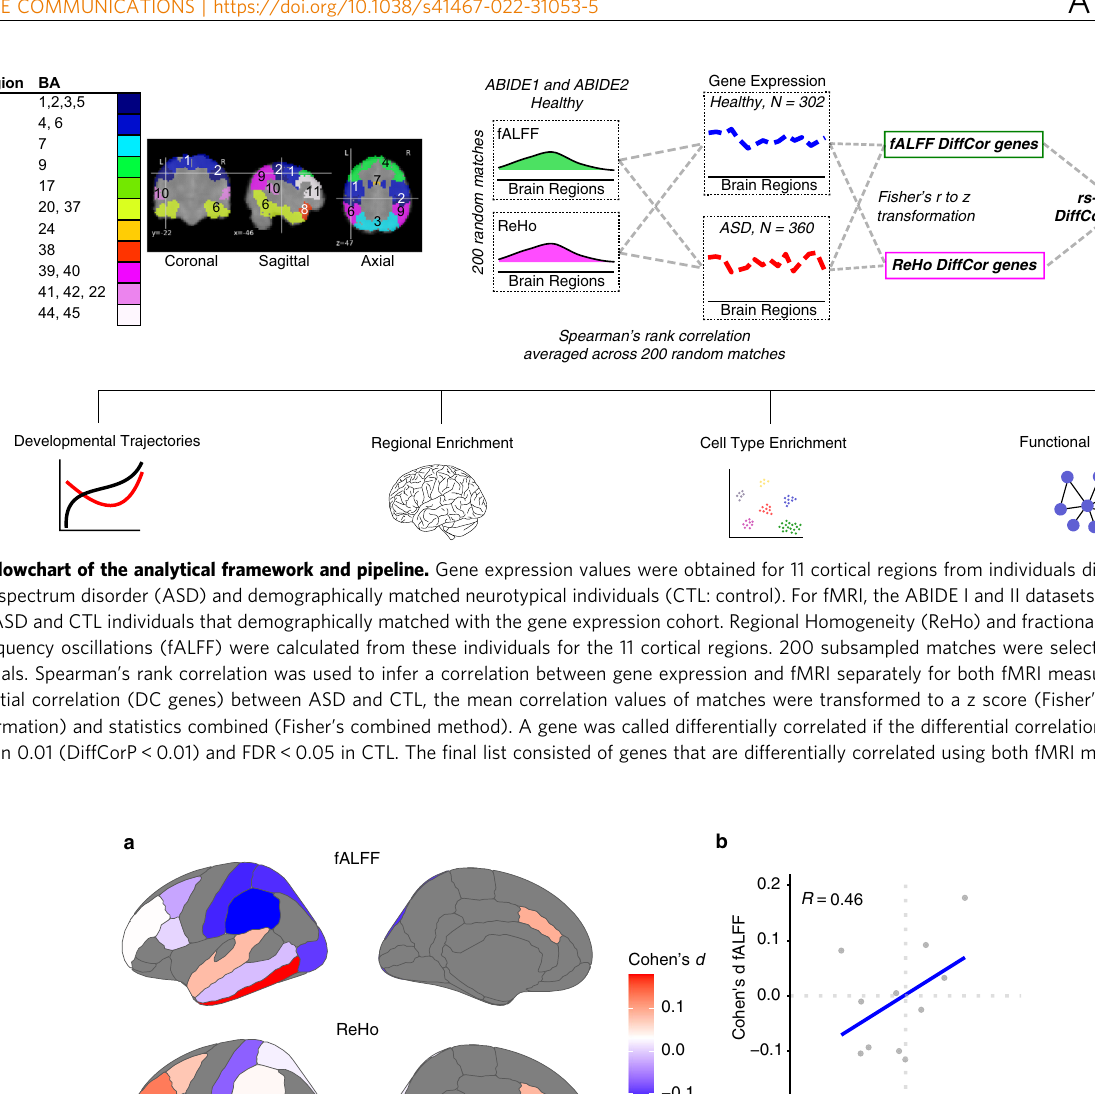
correlated each sample with the genomic data (see “ Methods ” ).